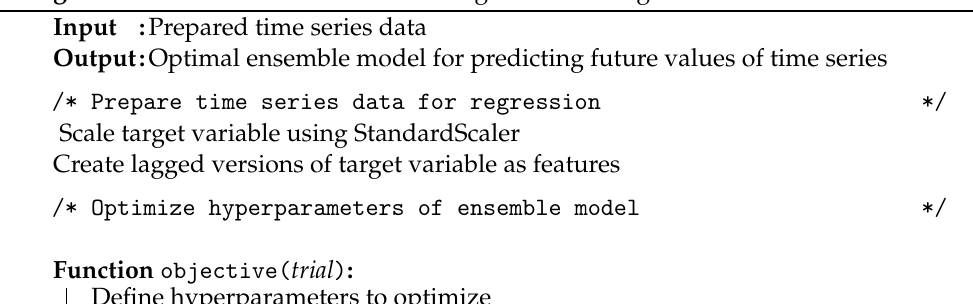
Algorithm 1: Time Series Prediction using Ensemble Regression